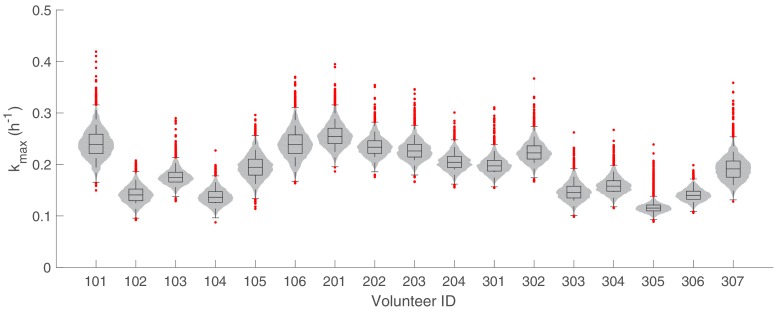
The marginal posterior distributions of the individual parameter of kmax (maximum rate of parasite killing by PQP) for all 17 volunteers.The violin plots (gray area) show the distributions of 5000 posterior samples. Box plots show the 25%, 50% (median) and 75% quantiles with outliers indicated by red dots. Relevant details of the individual parameter are provided in the Materials and methods in the main text.